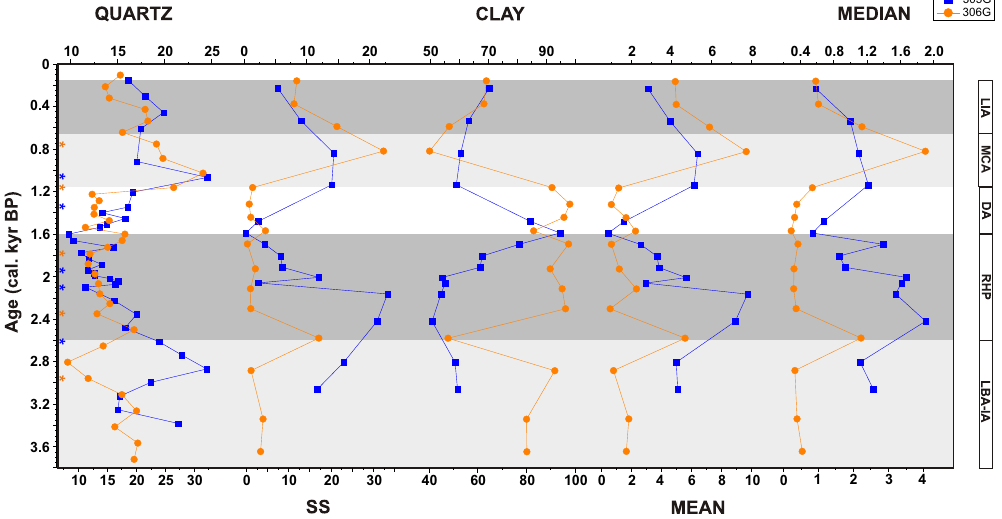
Fig. 7. Age-depth profile of grain size distribution: mean, median, SS (%), clay (%) and quartz content (%) for cores 305G (blue squares) and 306G (orange circles). Light grey bars indicate dry periods (MCA: Medieval Climate Anomaly, DA: Dark Ages, LBA-IA: Late Bronze Age-Iron Age); dark grey bars indicate humid periods (LIA: Little Ice Age, RHP: Roman Humid Period). Asterisks indicate the AMS 14 C